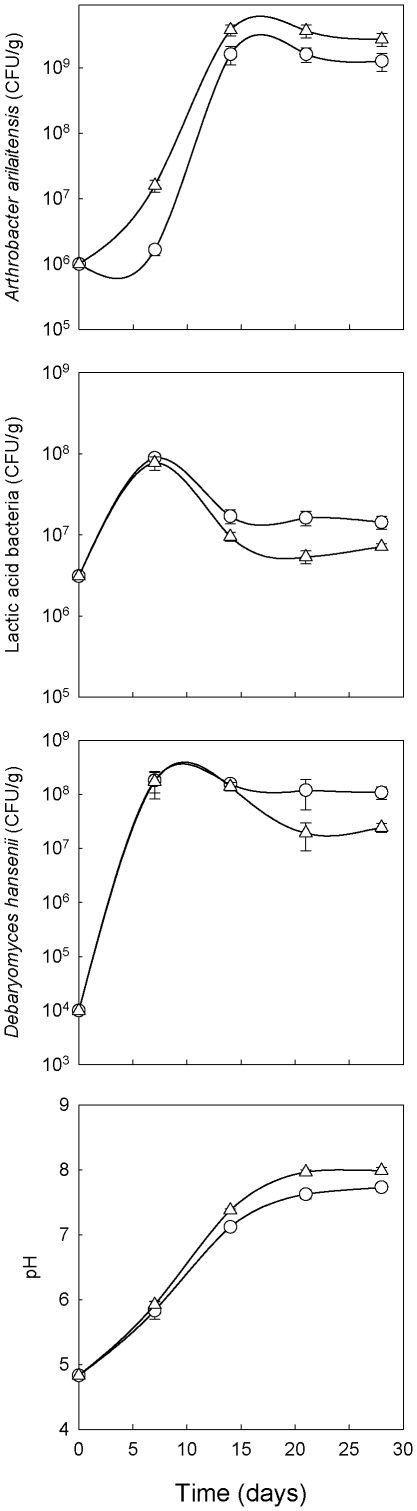
Stimulation of growth of A. arilaitensis in model cheeses by iron.Lactic curd was inoculated with 106 cfu/g of A. arilaitensis Re117 and 104 cfu/g the yeast Debaryomyces hansenii 304, without (○) or with (▵) addition of 1 mg iron per kg of curd. The values correspond to the means of three replications.